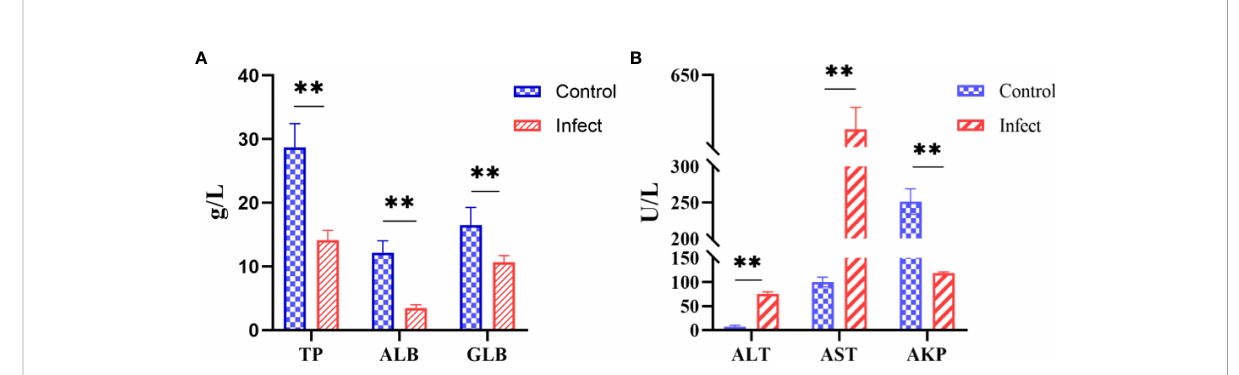
FIGURE 7 Serum biochemical indices. (A) Signi fi cant increase in alanine aminotransferase (ALT), aspartate aminotransferase (AST), alkaline phosphatase (AKP) ( P < 0.01). (B) Signi fi cant decrease in total protein (TP), albumin (ALB), and globulin (GLB) in the serum of sturgeon infected with D-59 ( P < 0.01). ** P <